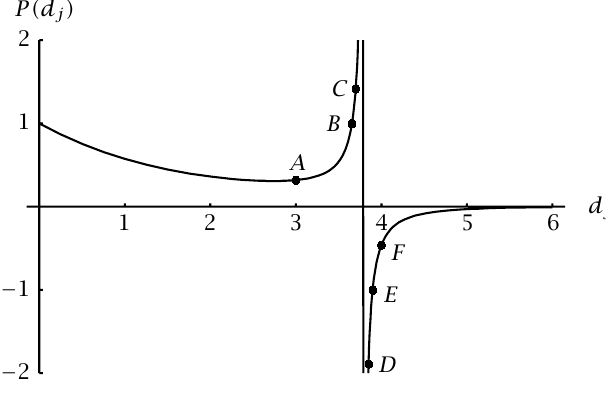
Figure 6.3 . Product ratio P(d j ) for b(t) = b cos (πt) , | b | > 1 and